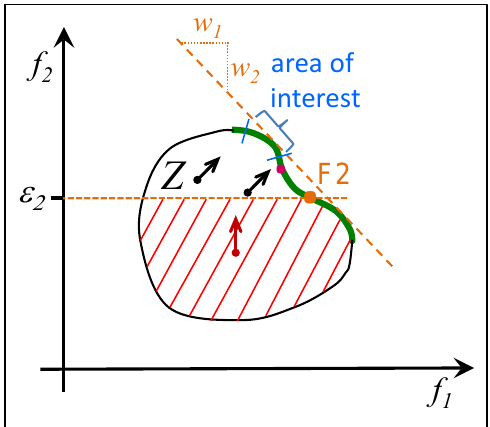
Figure 7. Cascaded weighted sum and region of interest for the example with a non-convex Pareto front given in Figure